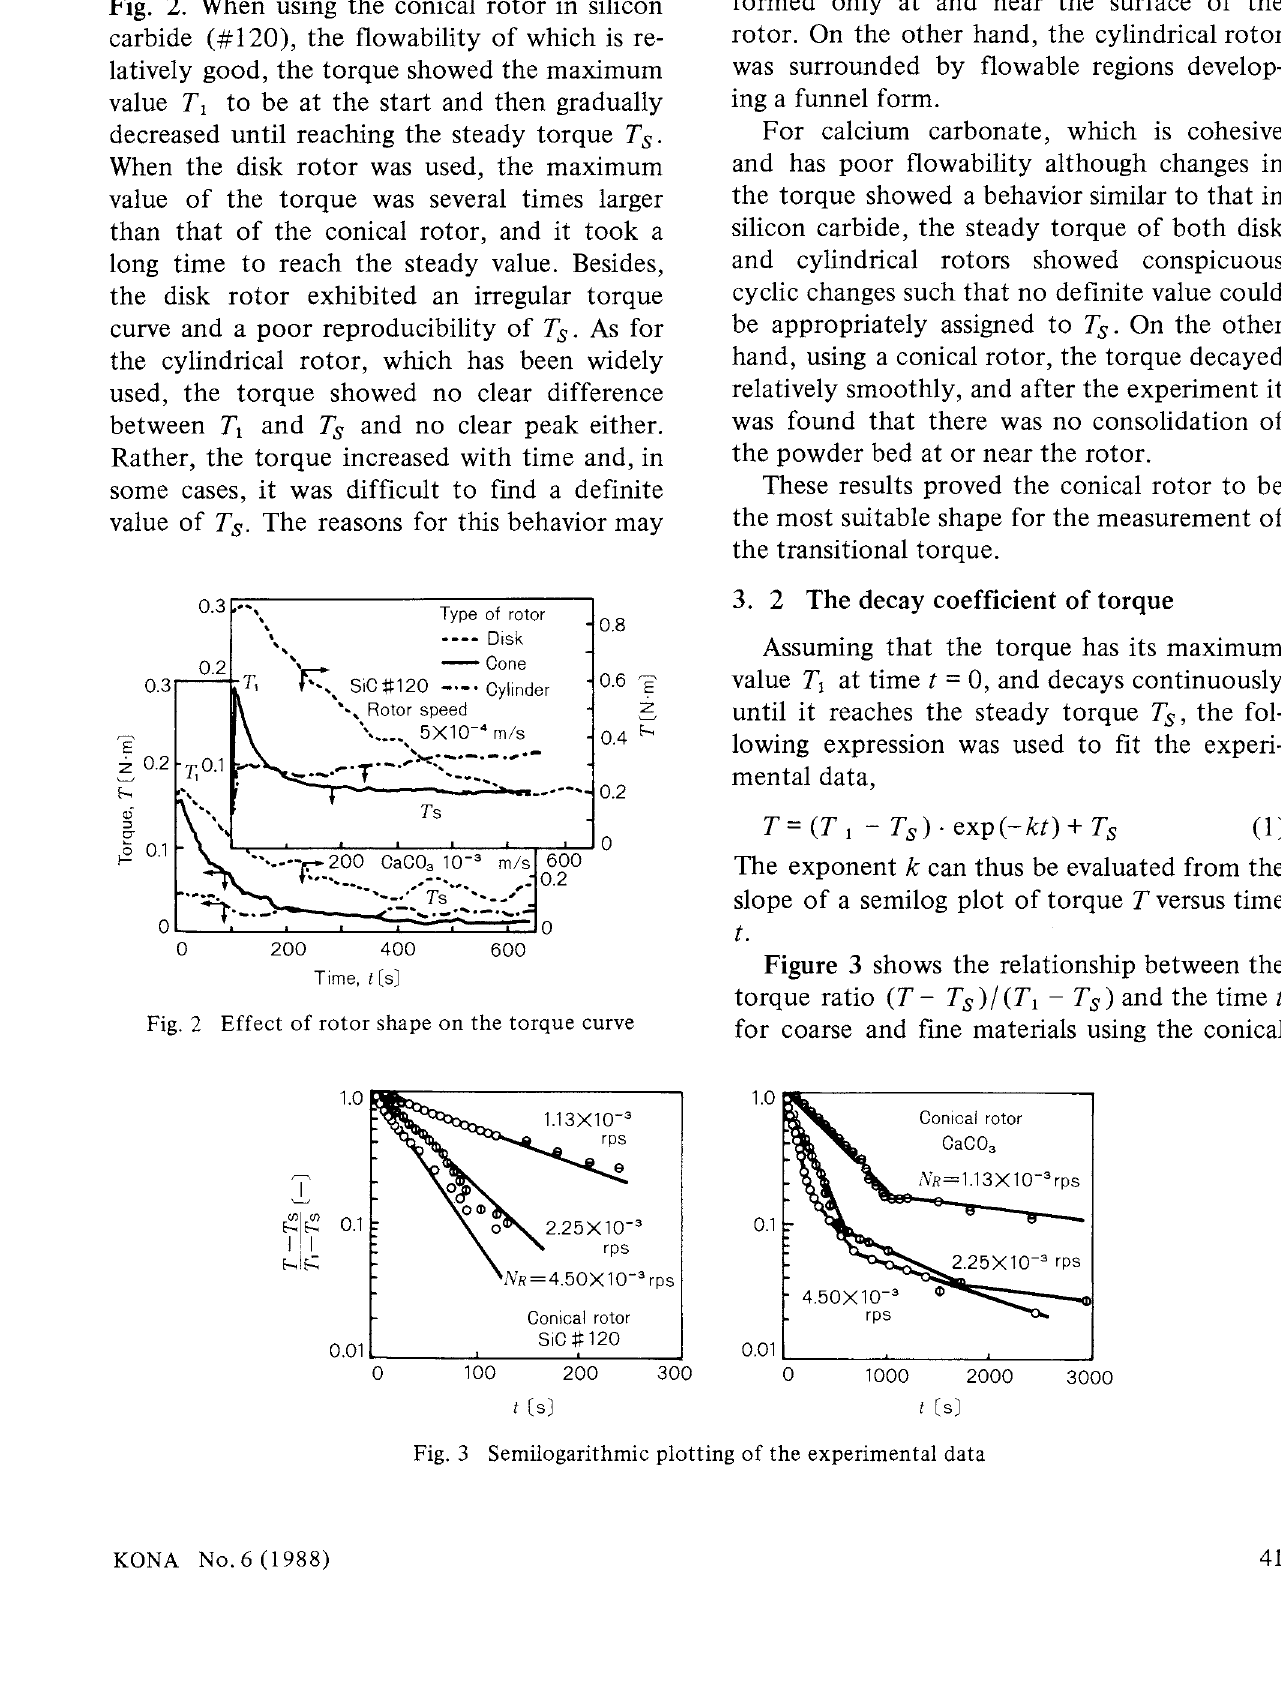
Fig. 2 Effect of rotor shape on the torque curve